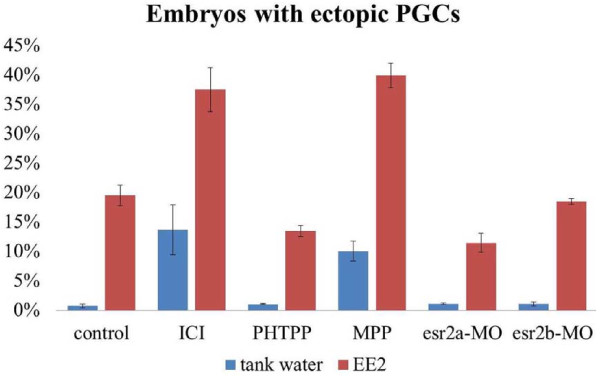
Embryos with ectopic PGCs in different treatment groups. In tank water, ICI and MPP treatment induced ectopic PGC distribution in 14% and 10% of the embryos, respectively. PHTPP, esr2a-MO, and esr2b-MO treatment did not disrupt PGC distribution. An increased percentage of fish with ectopic PGCs at 24 hpf was observed after exposure to EE2 compared with exposure to tank water alone (i.e., without EE2). Approximately 37% and 40% of the embryos displayed ectopic PGCs after exposure to ICI and MPP, respectively. Fewer embryos showed ectopic PGCs expression after exposure to PHTPP, and esr2a expression was reduced by approximately 13% and 11%, respectively. Inhibition of esr2b expression did not affect PGC distribution.